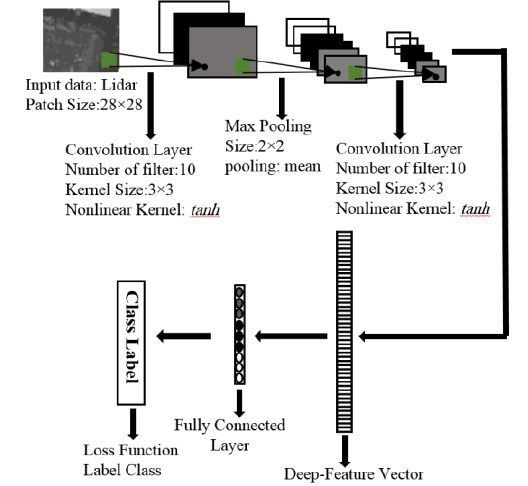
Figure 2. The architecture of the applied CNN for